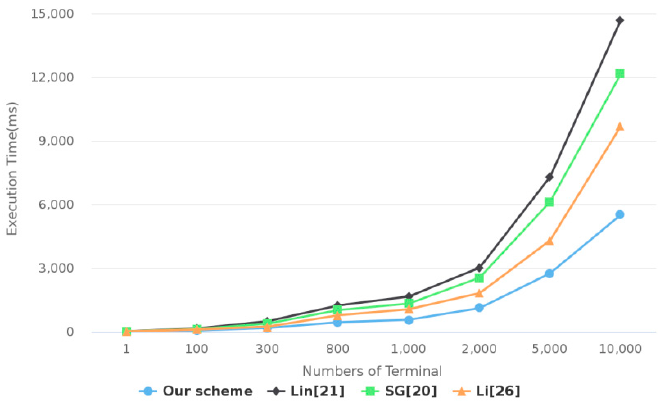
Figure 3. Comparison of the schemes’ execution time